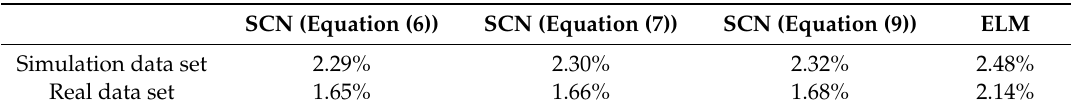
Table 5. Resource utilization of FPGA-based prediction models.